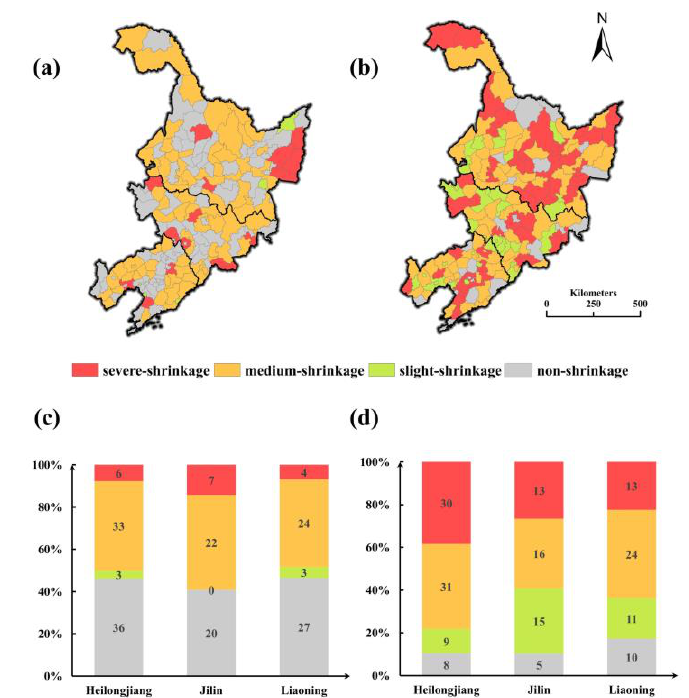
Figure 10. ( a ) The degree of shrinkage in S1 (1996–2009); ( b ) the degree of shrinkage in S2 (2010–2020); ( c ) the proportions of cities with different degrees of shrinkage by province in S1 (1996–2009); and ( d ) the proportions of cities with different degrees of shrinkage by province in S2 (2010 – 2020).